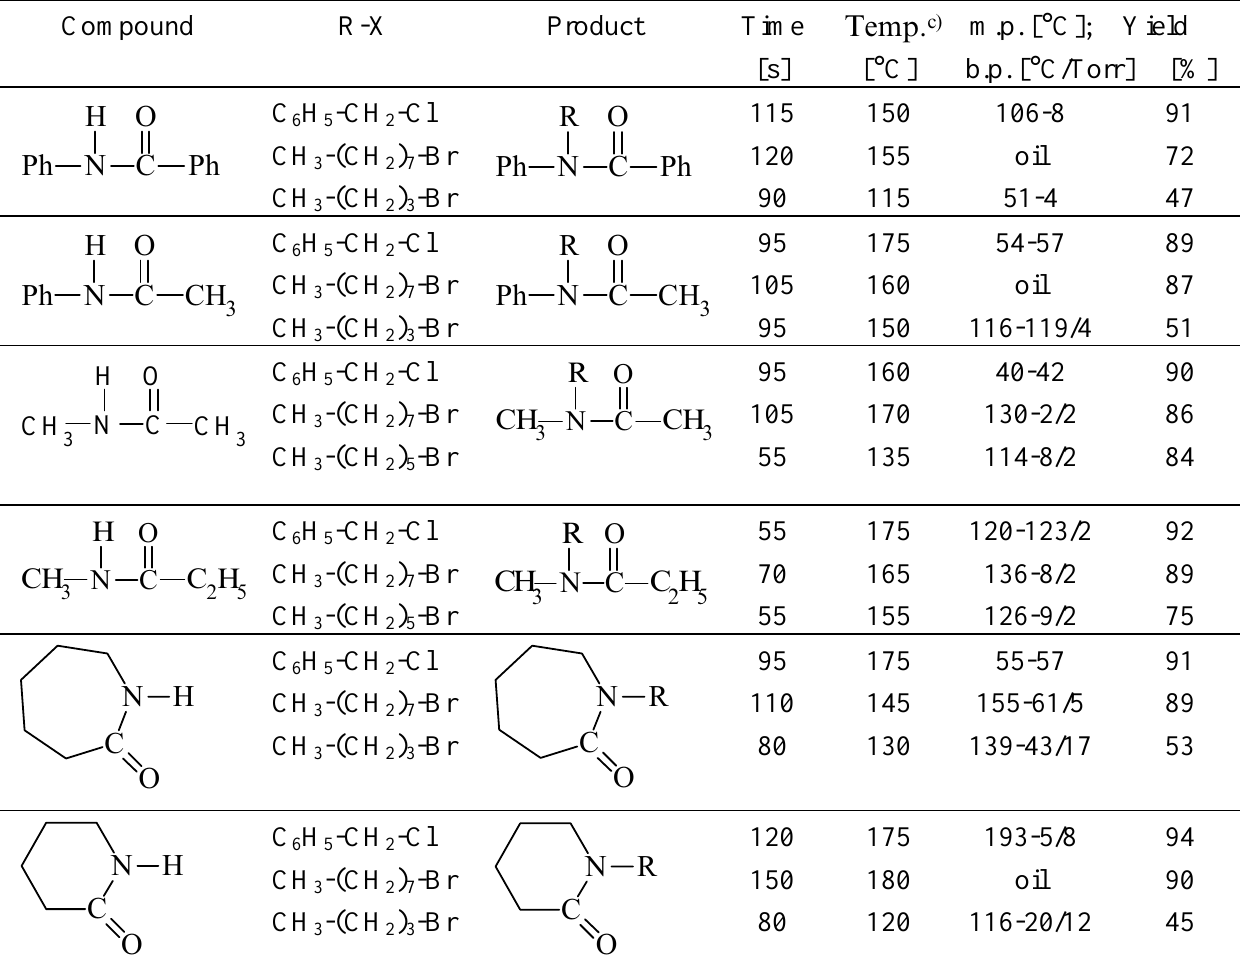
Table. Results of N- alkylation of amides and lactams under microwave irradiation in dry media a,b) .